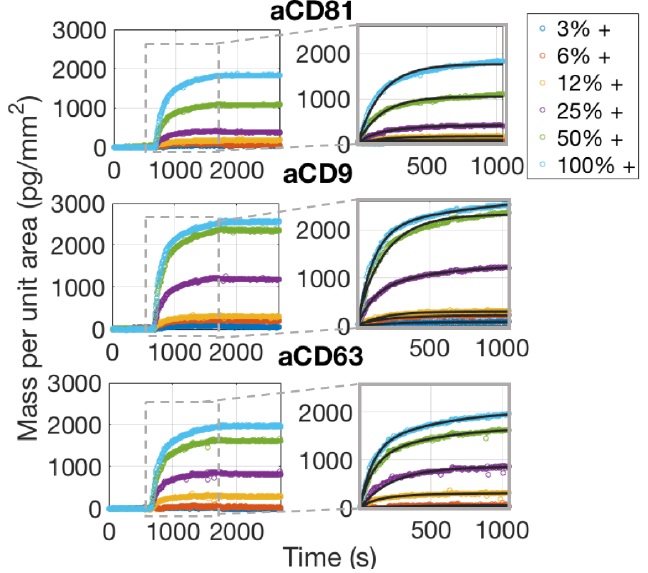
Figure 4. Binding curves of a generic IgG1 to one of the antibody chips used for the experiments. The insets focus on the association phase of the curves, which are fitted with a bivalent model.